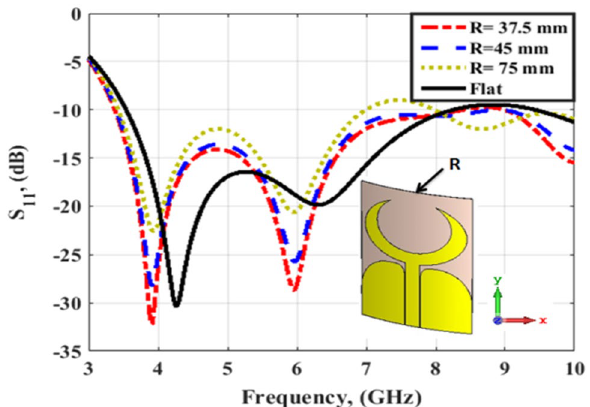
Figure 6. The flexible single antenna bending effect with three different radiuses.